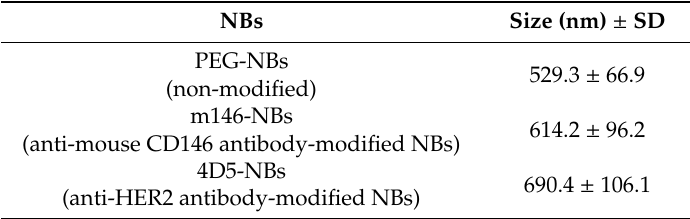
Table 1. Size of antibody-modified NBs and non-modified NBs.